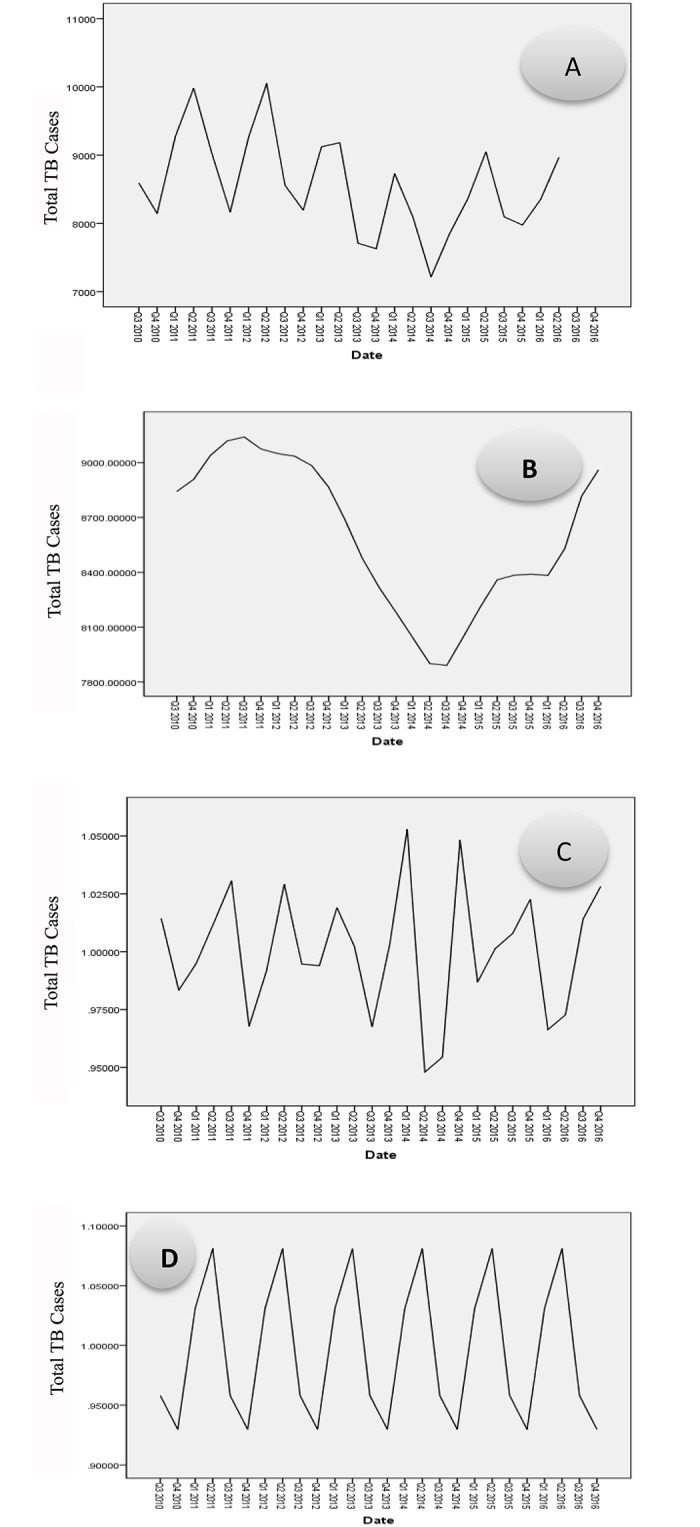
A sequence chart for original series and trend, seasonal, and irregular components,2010–2016.Quarters: Q1 is the first quarter (July-September); Q2 is the second quarter (October-December); Q3 is the third quarter (January-March) and Q4 is the fourth quarter (April-June) A. the original quarterly time series; B. is the decomposed time series into the trend cycle; C. is a seasonal trend; and D. is an irregular components.